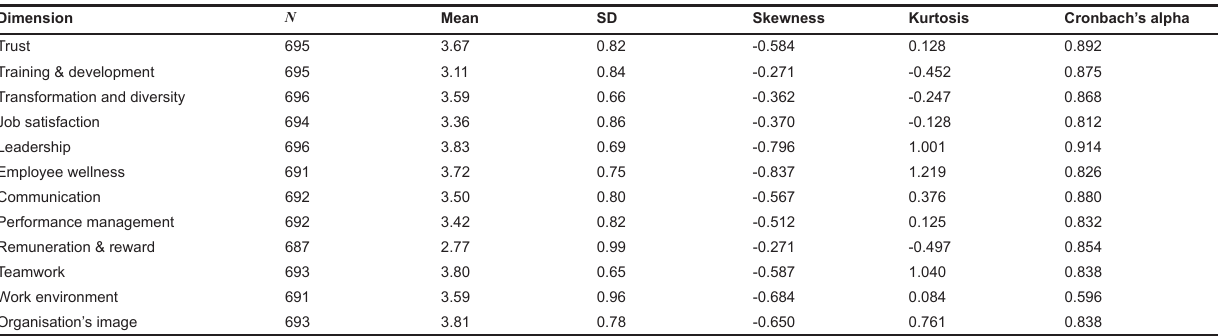
Table 4 Descriptive statistics and reliability of scales of the organisational climate questionnaire